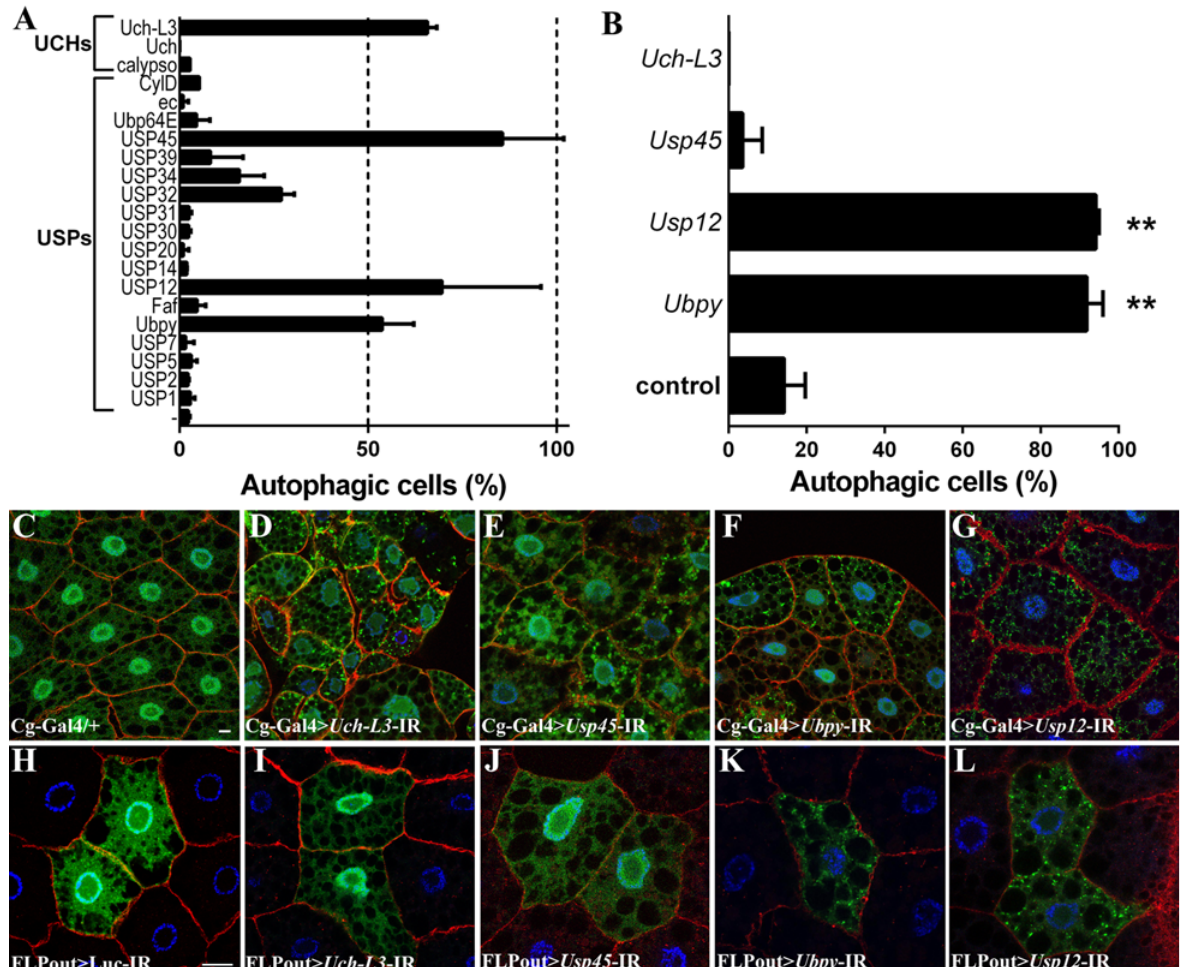
Fig 1. A genetic screen identifies UBPY and USP12 as putative autophagy regulators. (A) Quantification of autophagy in the Drosophila larval fat body after silencing of the indicated DUB using the Cg-Gal4 driver line. Bars denote the proportion of autophagic cells from at least 6 animals. Cells were considered as “ autophagic ” if at least one GFP-LC3B vesicle was observed. (B) Quantification of autophagy after silencing by the FLPout method. Bars denote the proportion of autophagic cells from at least 6 animals. Statistical significance was determined using one-way ANOVA : ** p < 0.005. (C-G) Representative confocal sections after silencing of the indicated DUB in the larval fat body. (H-L) Clonal analysis of the four candidates after silencing by the FLPout method. One representative confocal section per genotype is shown. Actin is labelled with Phalloidin-Texas Red (red) and nuclei are labelled with Hoechst (blue). Scale bar: 10 μ m. Genotypes: (C) Cg-Gal4/+; UAS-GFP-LC3B/+ , (D) Cg-Gal4/ UAS-Uch-L3-IR; UAS-GFP-LC3B/+ , (E) Cg-Gal4/ UAS-Usp45-IR; UAS-GFP-LC3B/+ , (F) Cg-Gal4/+; UAS-GFP-LC3B/ UAS-Ubpy-IR , (G) Cg-Gal4/+; UAS-GFP-LC3B/ UAS-Usp12-IR , (H) y w hs-FLP/+; UAS-GFP-Atg8a/UAS-Luc-IR; Ac > CD2 > Gal4/+ , (I) y w hs-FLP/+; UAS-GFP-Atg8a/UAS-Uch-L3-IR; Ac > CD2 > Gal4/+ , (J) y w hs-FLP/+; UAS-GFP-Atg8a/ UAS-Usp45-IR; Ac > CD2 > Gal4/+ , (K) y w hs-FLP/+; UAS-GFP-Atg8a/+; Ac > CD2 > Gal4/ UAS-Ubpy-IR , (L) y w hs-FLP/+; UAS-GFP-Atg8a/+; Ac > CD2 > Gal4/ UAS-Usp12-IR .